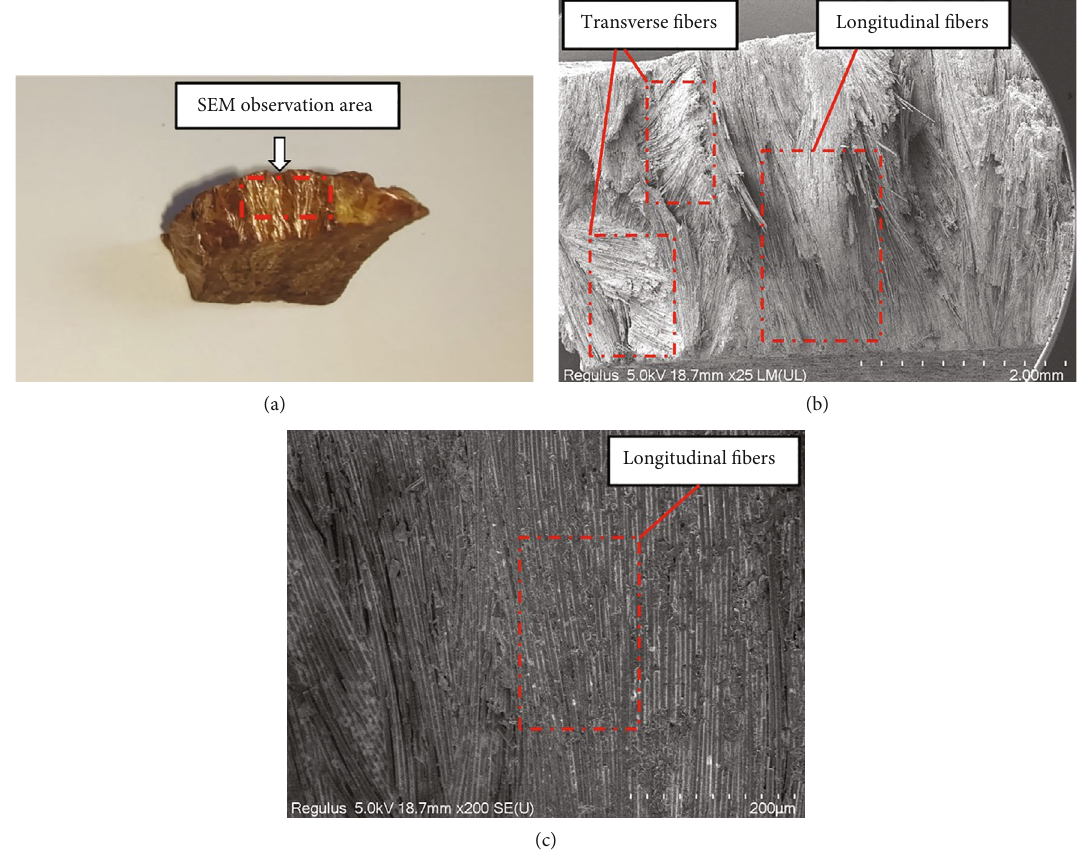
Figure 4: SEM microstructure of weak arrangement: (a) observation area, (b) 2.00mm, and (c) 200 μ m.